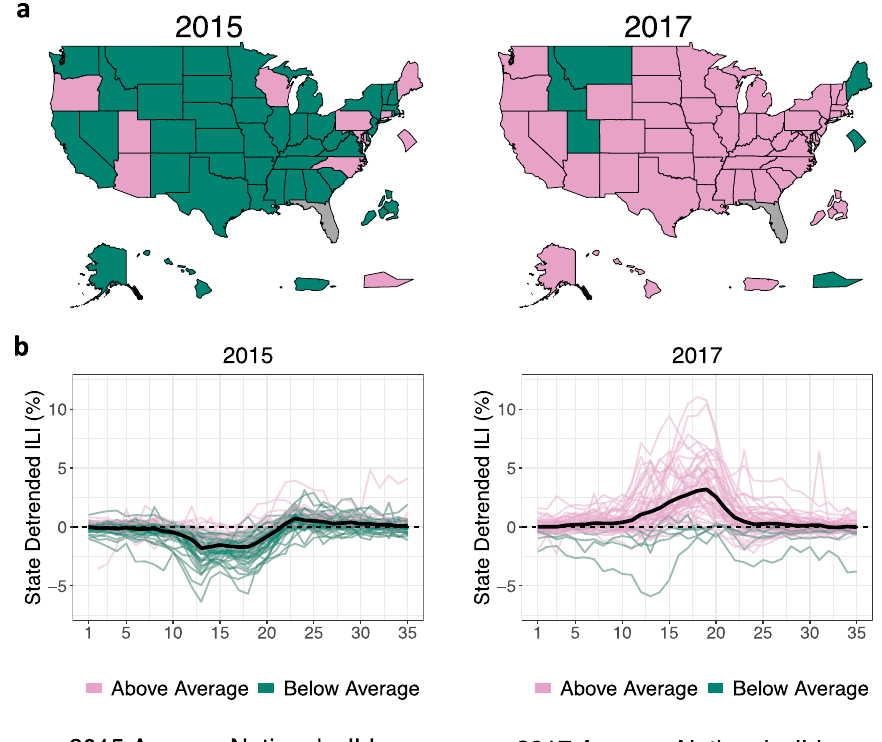
Fig. 2 Seasonal in fl uenza-like illness variability. a Dark green states denote states with ILI less than their state-speci fi c averages while pink states are states with ILI above their state-speci fi c averages. 2015 was a mild fl u season for the majority of states relative to their state-speci fi c average ILI, while 2017 was an intense fl u season for the majority of states, indicating that season-to-season effects can affect most of the country. Data unavailable for Florida. States displayed outside of the contiguous US are geographically not to scale. b State detrended ILI for the 2015 and 2017 fl u seasons, where state detrended ILI is ILI for a state/season minus ILI for that state averaged over all seasons. Positive/negative state detrended ILI means ILI for that season was above/below the state-speci fi c average, respectively. Black line is season-speci fi c national average wILI for reference.